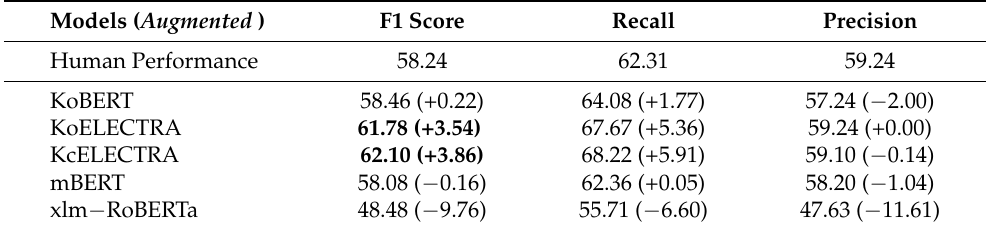
Table 5. Performance of human and various data augmented language models. We utilized five Korean and multilingual models for baseline architecture. As a result, all of the Korean models with data augmentation strategies achieve higher F1